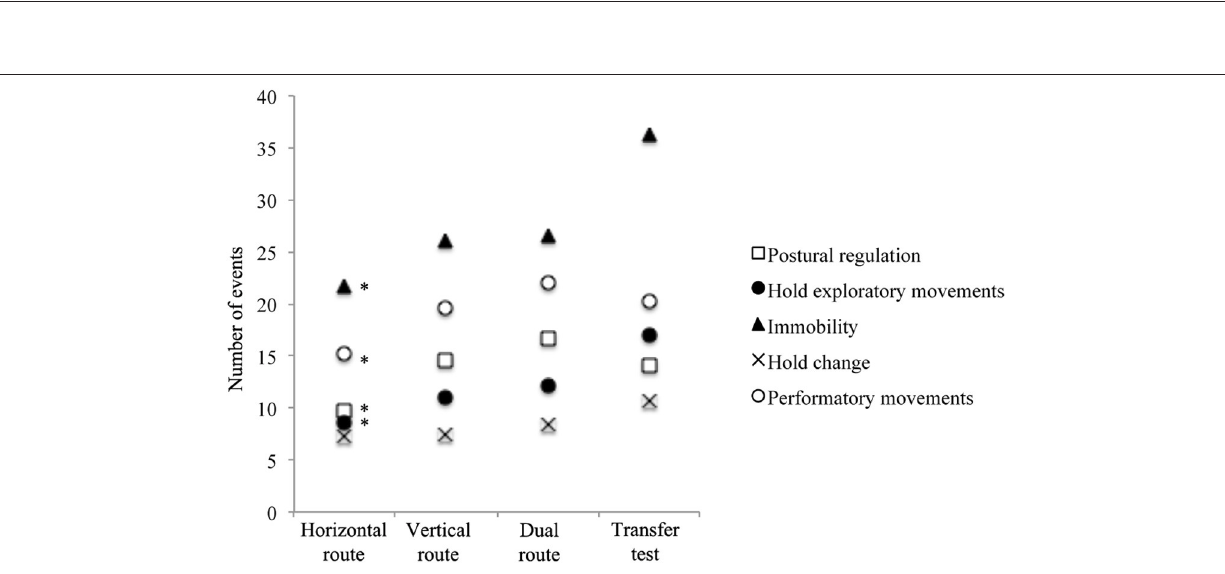
Frontiers in Psychology | www.frontiersin.org